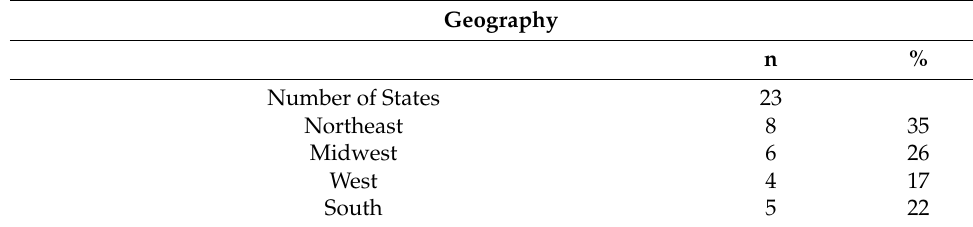
Table 1. Mobile Market Organization